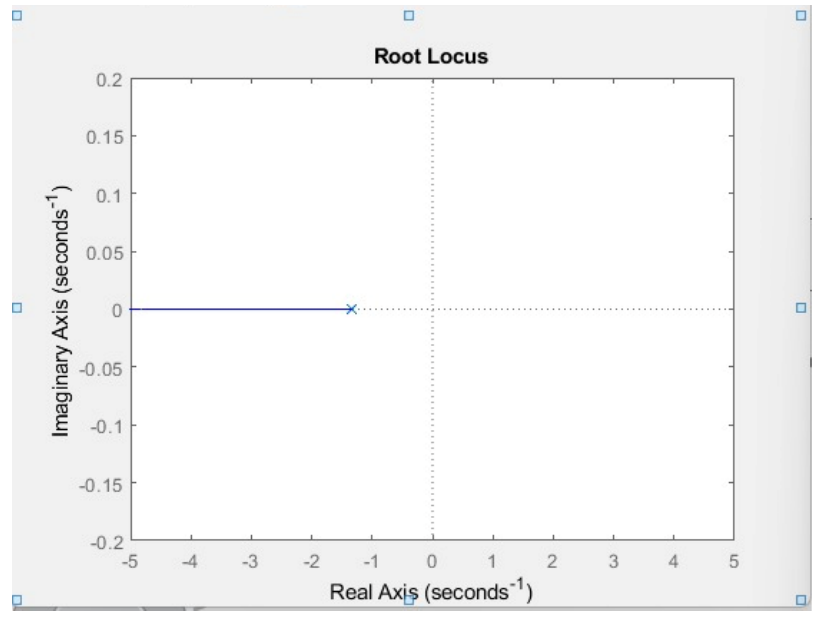
Figure 20. Root locus plot of electrolysis system.